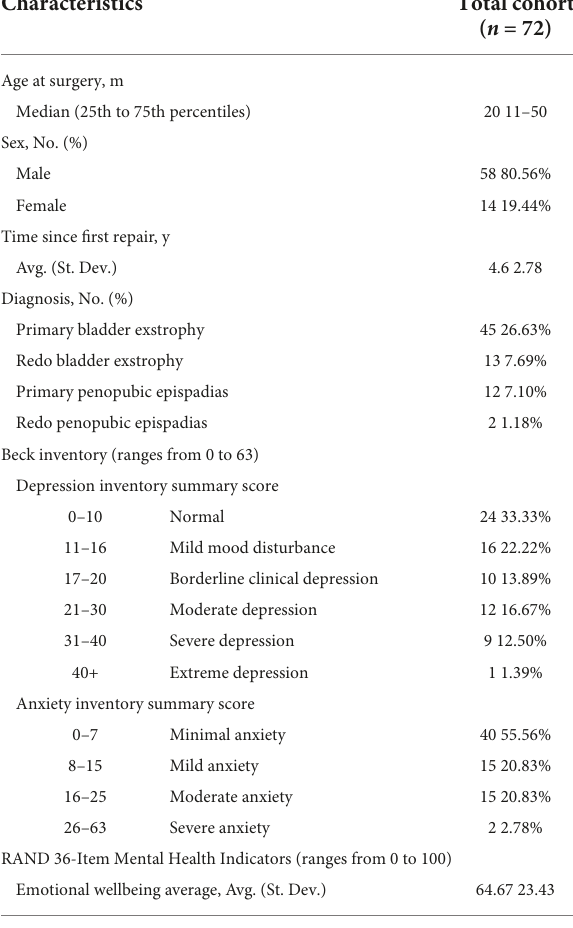
TABLE 3 Cohort characteristics and mental health indicators.